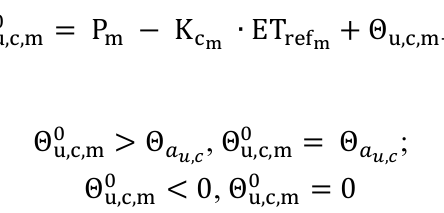
) of the vegetation period and the months (cid:2913) (cid:3171)